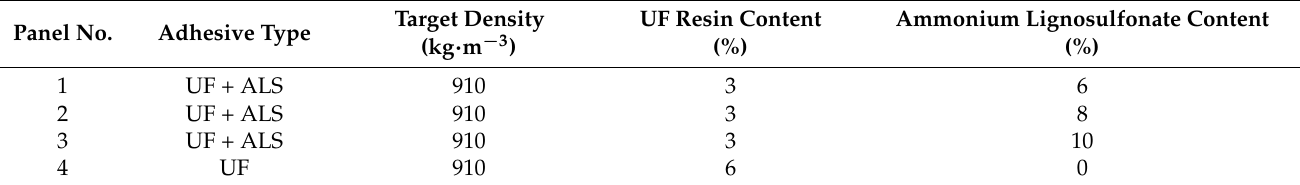
Table 1. Manufacturing parameters used in this research